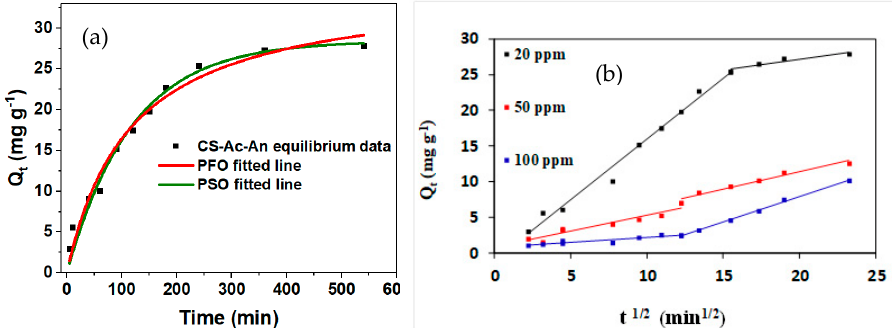
Figure 7. ( a ) Kinetic adsorption profile of Cu(II) uptake with CS-Ac-An at ambient pH (6.5–7) and 23 ◦ C that were fit by the PFO and PSO models. Cu(II) concentration: 20 mg L − 1 , volume: 100 mL, and adsorbent dosage: 100 mg. ( b ) Kinetic data analyzed by the Weber and Morris model for variable Cu(II) concentration at ambient pH (6.5–7) and 23 ◦ C. Cu(II) concentration: 20, 50, and 100 mg L − 1 ; volume: 100 mL; and adsorbent dosage: 100 mg.